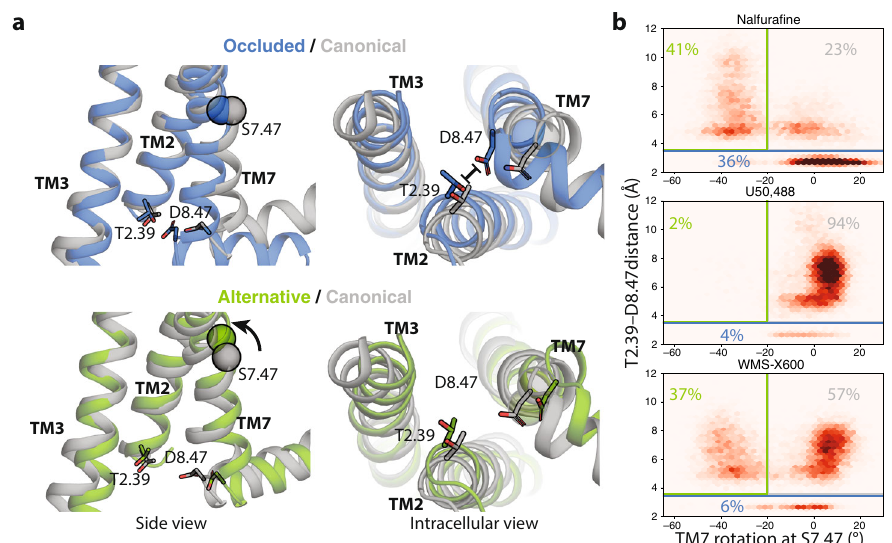
b DensityplotsofthedistancebetweenthecarboxylateoxygensofD334 8.47 andthe hydroxyl oxygen of T94 2.39 and the rotation ofTM7 atthe S324 7.47 (see “ Methods ” ). Simulation frames were classi fi ed as being in the occluded state if the T94 2.39 – D334 8.47 distance is less than 3.5Å and otherwise in the alternative state if the TM7 rotation is less than − 20° or else in the canonical active